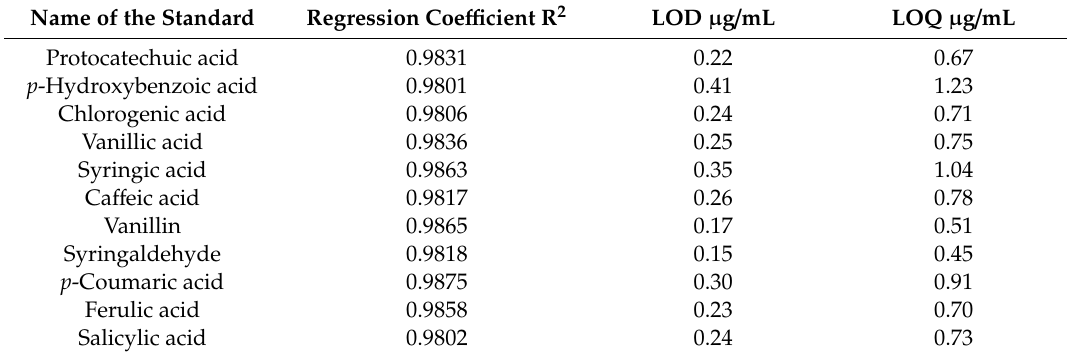
Table 5. Regression coe ffi cient, LOD, and LOQ of phenolic compounds